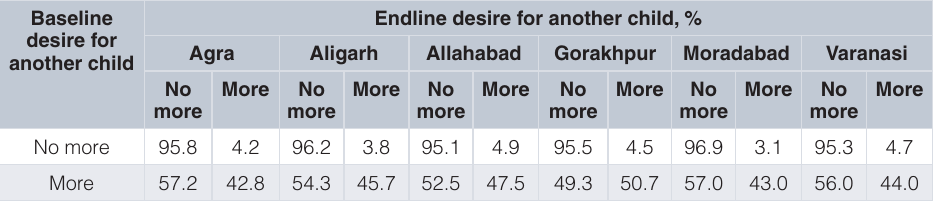
Table 3. City-specific change in fertility desires between baseline to